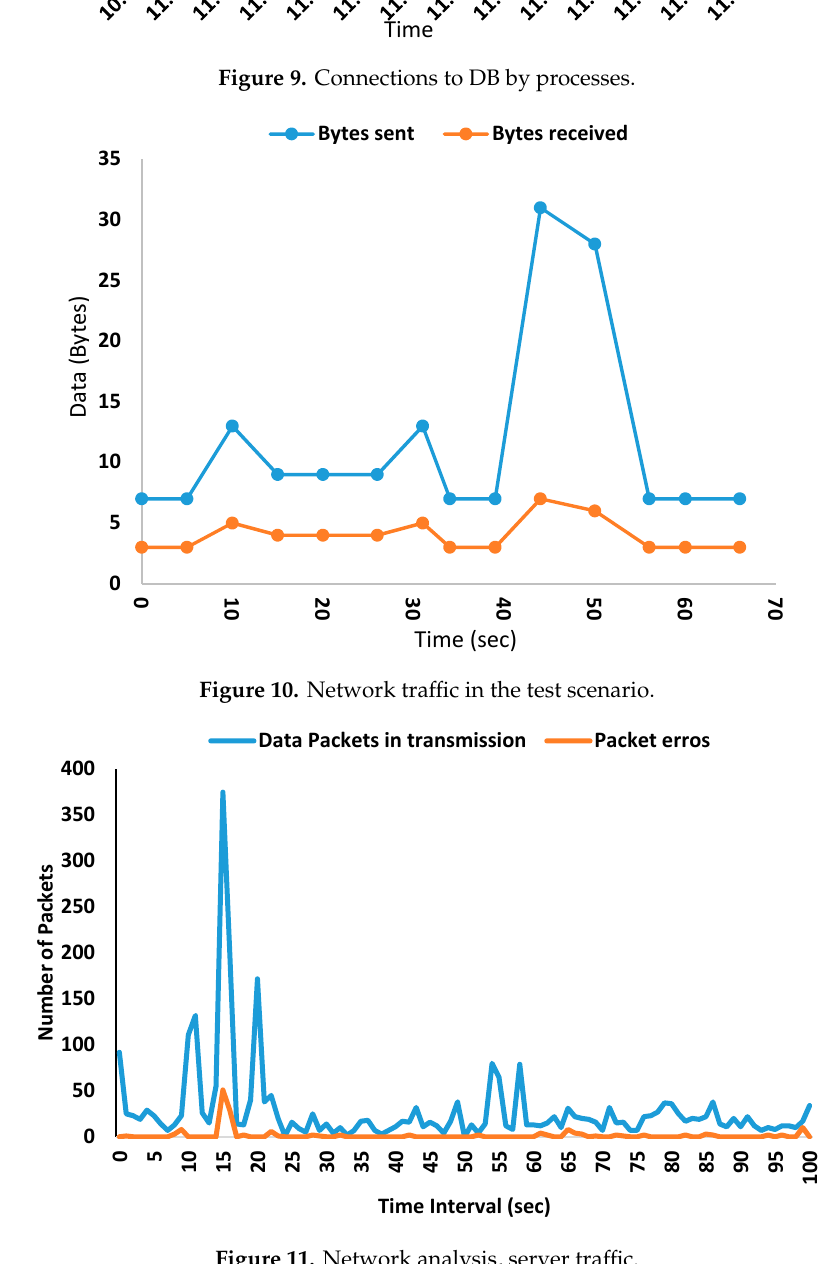
Figure 9. Connections to DB by processes.